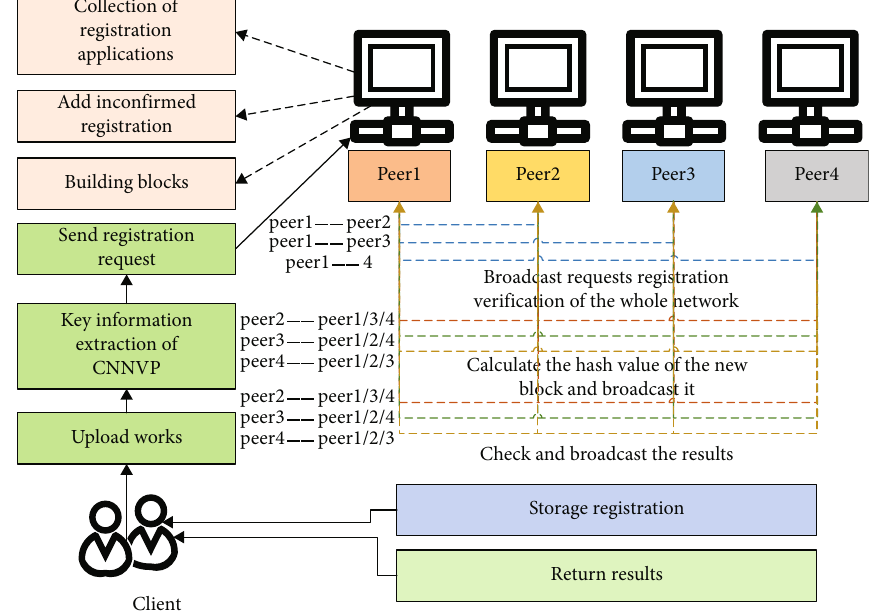
Figure 10: The fl ow chart of registration